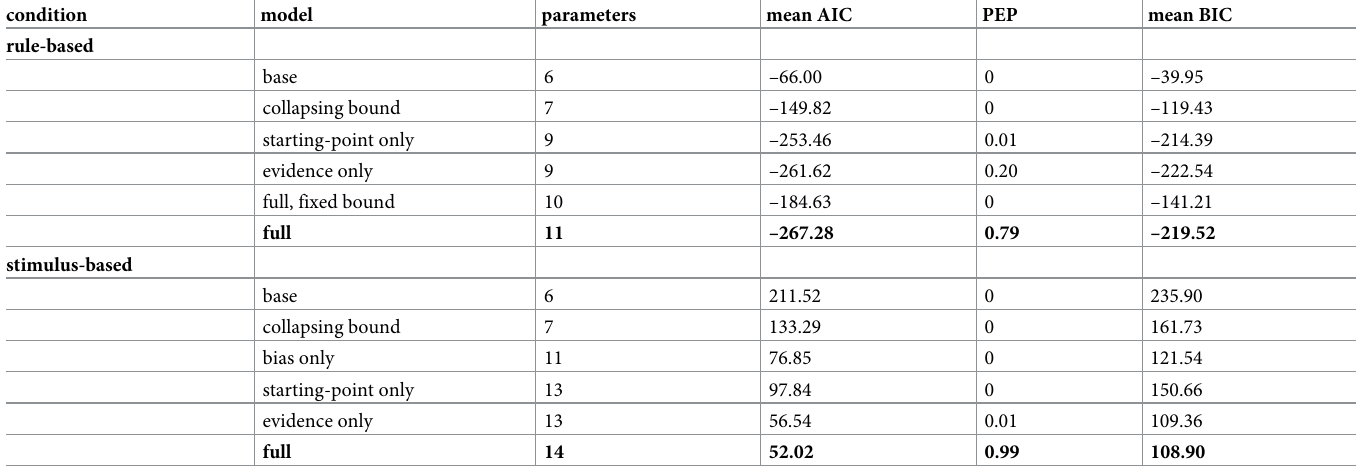
Table 3. DDM model-fit comparisons. All models included evidence-acculumulation and starting-point bias terms to account for idiosyncratic biases, even when they did not include cue-dependent bias terms. See Methods for full implementation details. We selected best-fitting models (bold) on the basis of AIC and